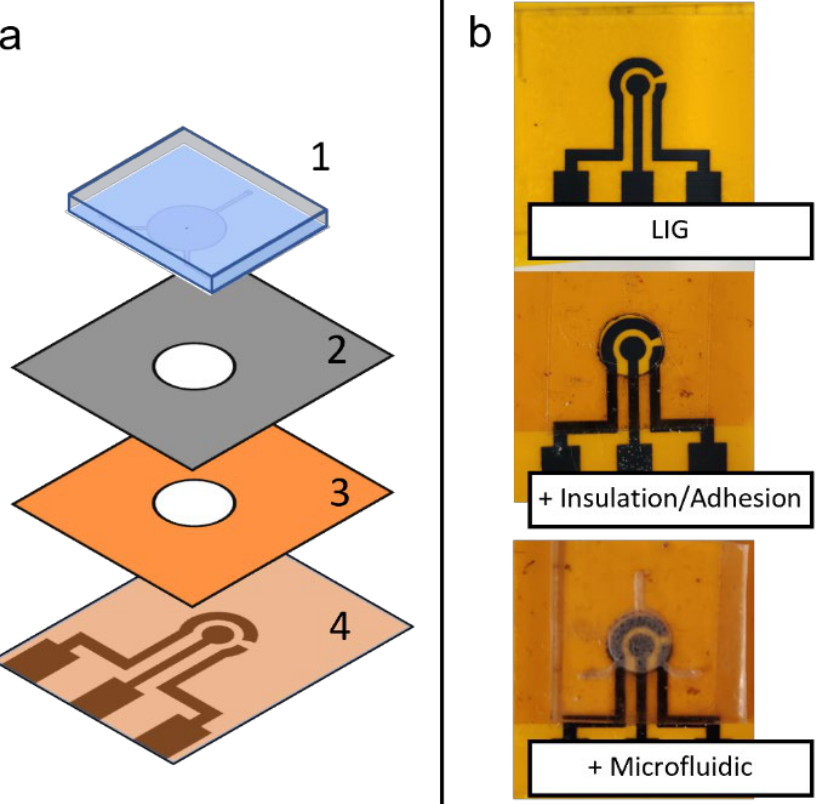
Figure 3. ( a ) Schematic depiction of assembly of a flexible microfluidic sensing device, showing the different layers of materials: (1) PDMS microfluidic chip, (2) adhesion layer and (3) insulation layer with circular cutout, and (4) LIG electrode unit. ( b ) Photographs of the assembly process, showing different layers being added on top of previous layers.